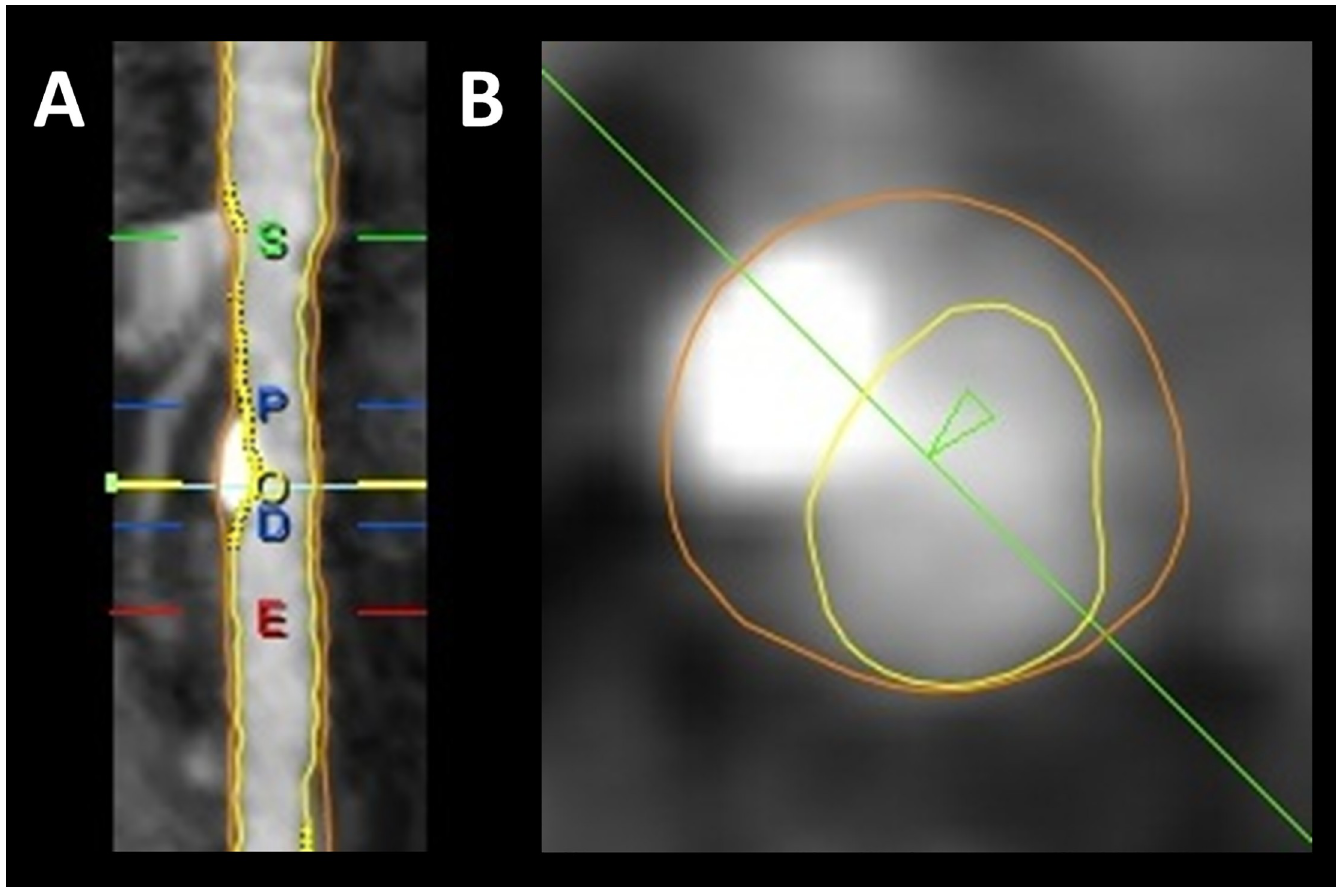
Fig 1. Example of quantitative analysis of a proximal left anterior descending artery segment. A. Longitudinal straightened multiplanar reconstruction where S and E are the start and end of the segment, respectively; P and D are the proximal and distal borders of the lesion, respectively; O is the point of maximal obstruction. B. Transverse vessel view at the point of maximal obstruction.